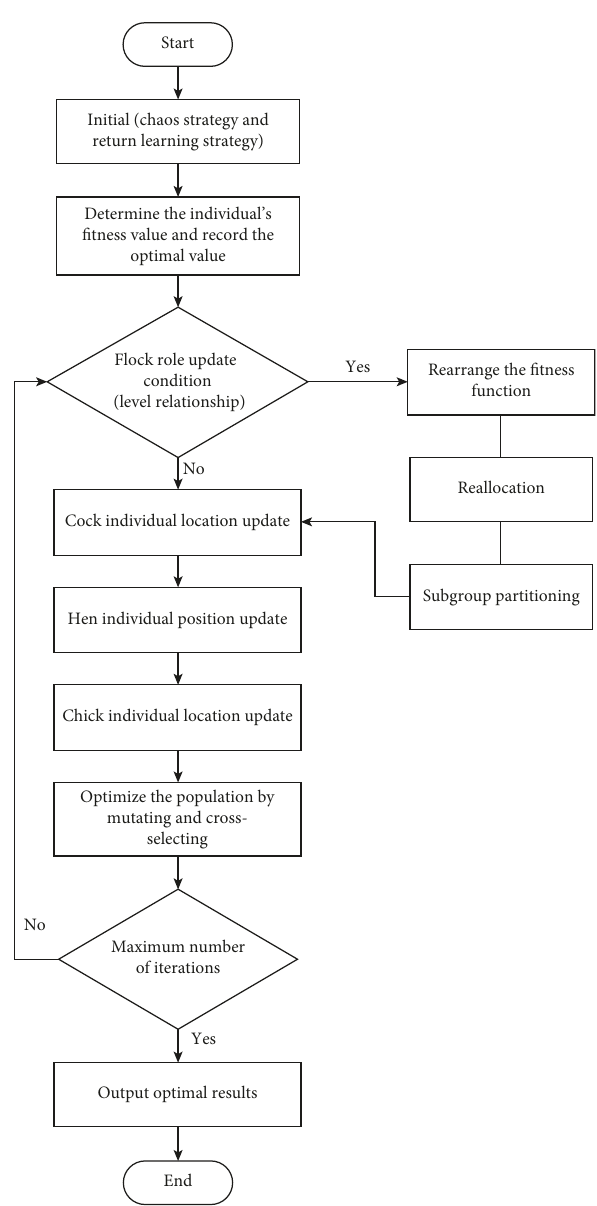
Figure 1: Flow chart of improved chicken swarm